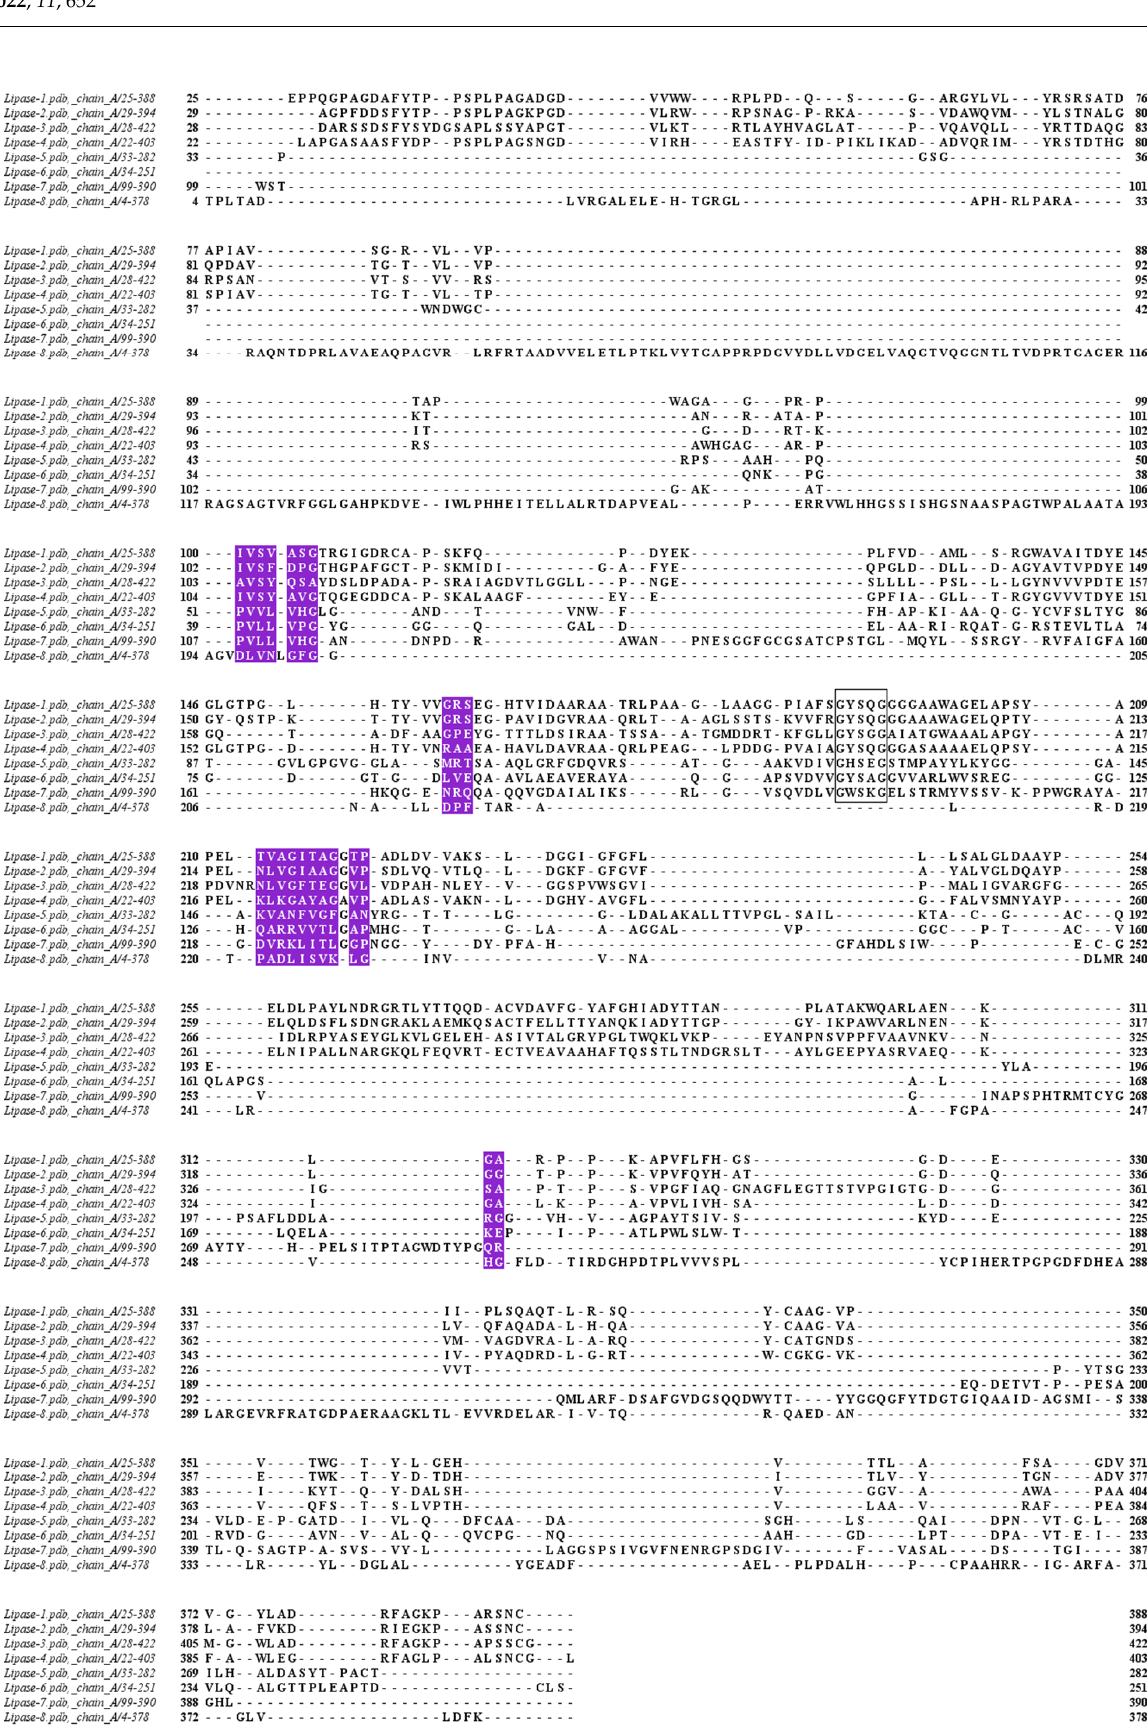
Figure 5. The proteins sequences were aligned using Chimera with defaults parameters. Structurally conserved regions are shown in